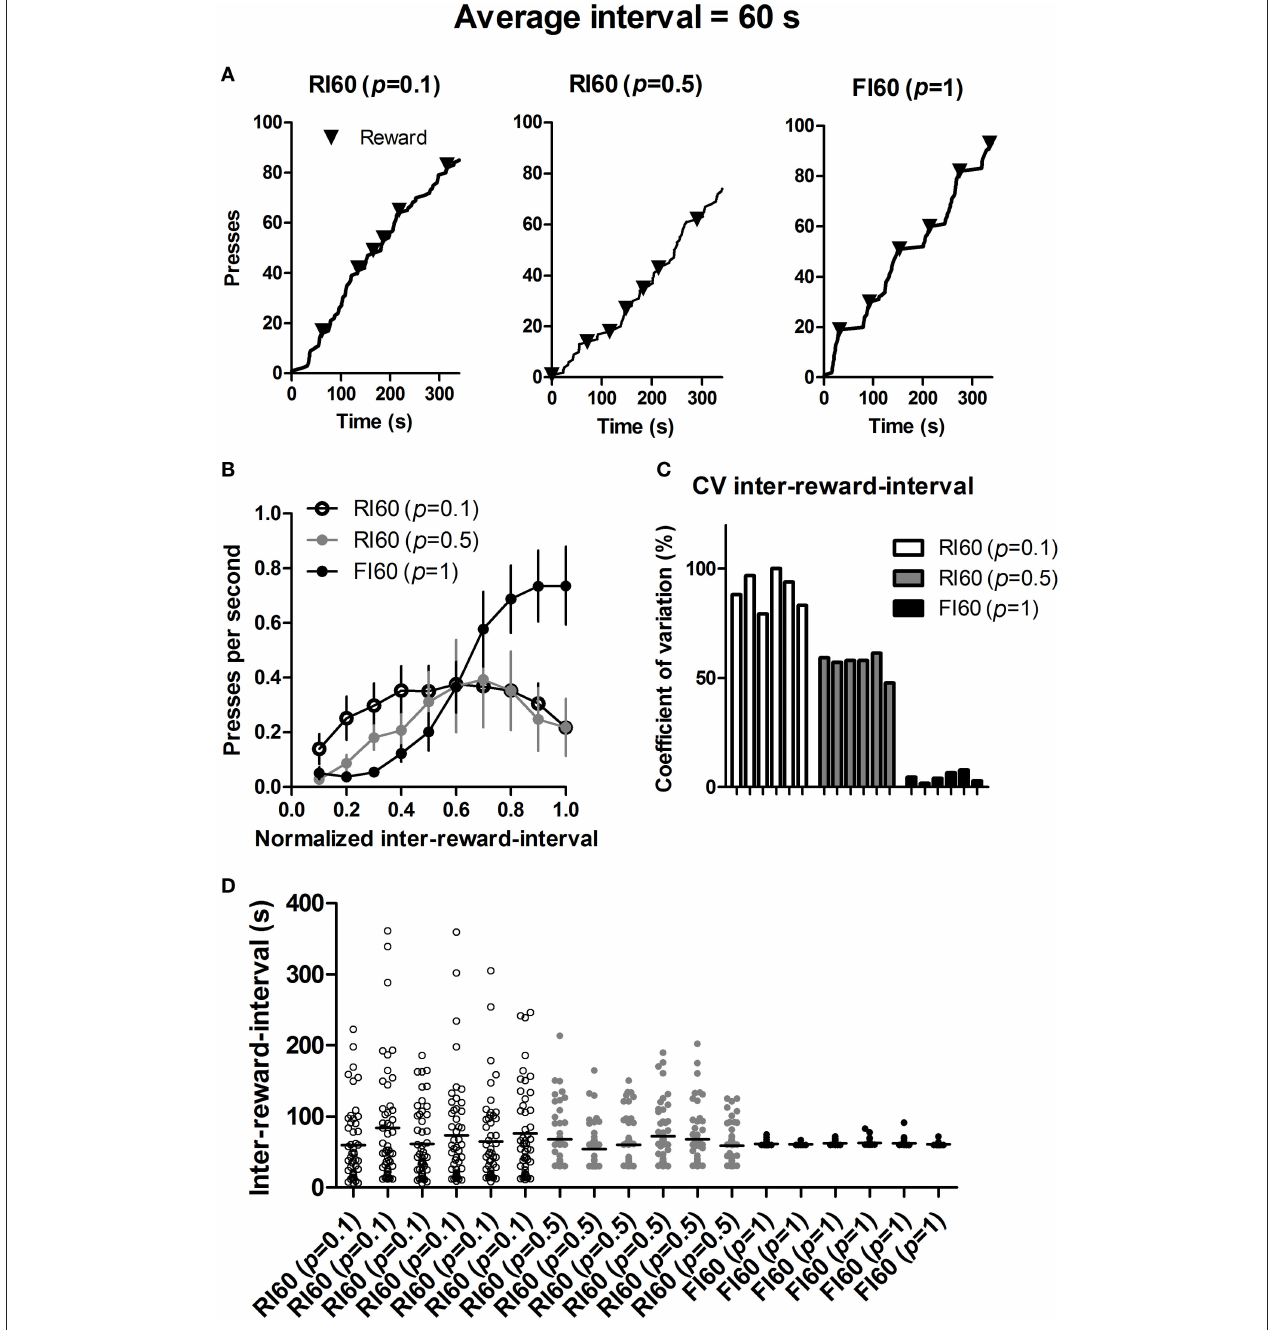
FIgure 5 | Behavior under different interval schedules during the last session of training before the second devaluation test. (A) Representative cumulative records of mice (randomly selected 300 s trace) from the three groups. (B) Rate of